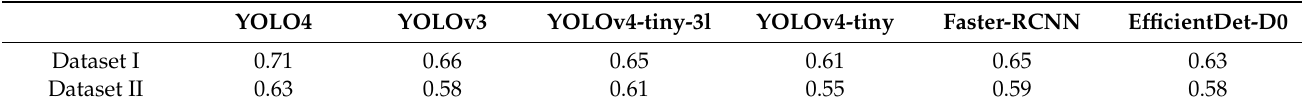
Table 3. Result after first step, showing that single-class methods had better results.